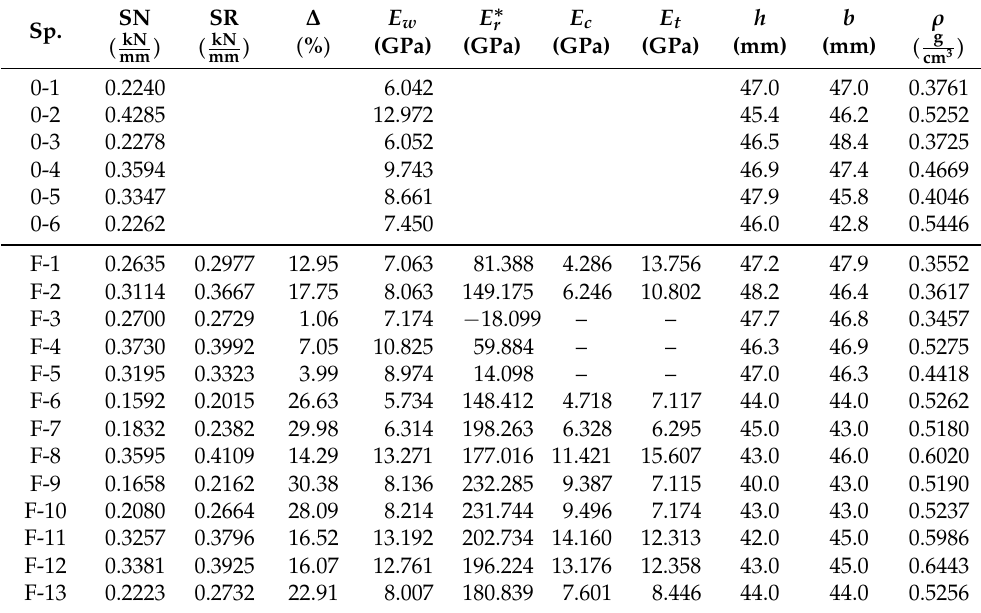
Table 2. Summary of stiffness and moduli of bending test specimens in groups of non-reinforced beams (0) and beams reinforced with CFRP fabric (F). Slopes of the load–deflections curves are obtained by linear regression in the linear elastic range for all groups in the non-reinforced stage (SN). Slopes for the reinforced group after reinforcement are given by SR with increment ∆ . Calculated moduli of elasticity for the wood are denoted by E w , and the hypothetical moduli of the reinforcement (assuming the calculated E w ) by E ∗ r . Cross-sectional height ( h ) and width ( b ) as well as wood density ( ρ ) are also shown. Empty cells indicate data not applicable. Dashes (–) are displayed where results are not computed due to measurement faults.